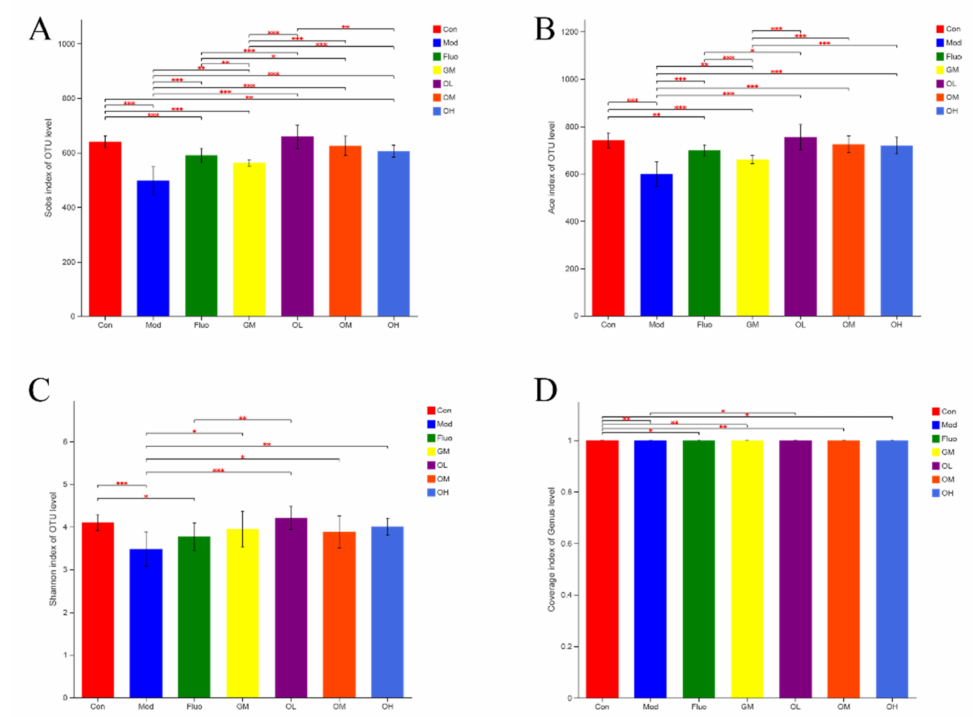
Figure 5. Comparison analysis of the difference in the α diversity index of gut microbiota among different groups. ( A ). Difference in Sobs index. ( B ). Difference in Ace index. ( C ). Difference in Shannon index. ( D ). Difference in Coverage index. (* p < 0.05, ** p < 0.01, *** p <